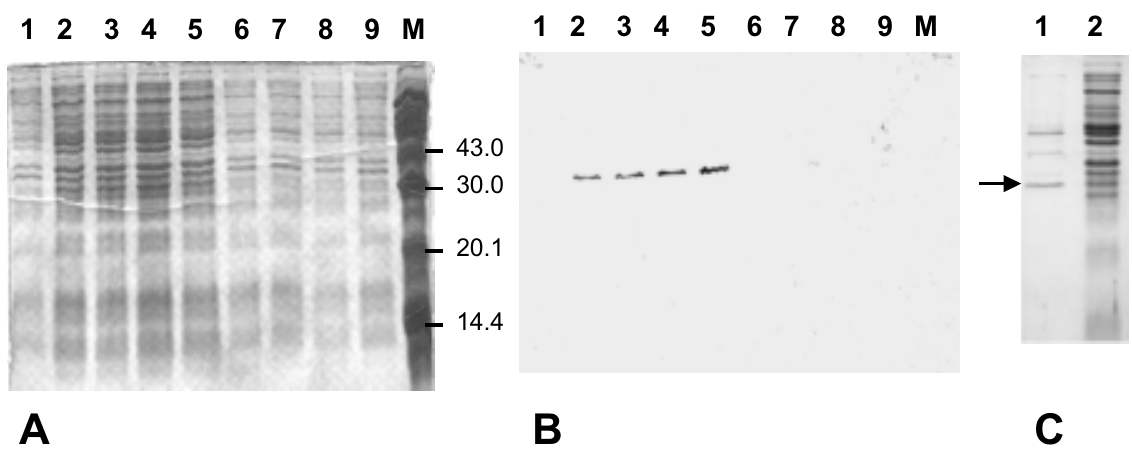
Fig. 1. Analysis by SDS-PAGE (15%) and Western blot of cellular extracts of Escherichia coli cultures harbouring the expression vector pTrcHisA 19-21. Panel A) SDS PAGE (15%) analysis of cellular extracts of cultures grown at 37 ° C (lanes 1 to 5) and 24 ° C (lanes 6 to 9). Lane 1, time 0, expression not induced. Lanes 2 and 3, respectively, 3 h and 5 h after induction with 0.3 mM IPTG. Lanes 4 and 5, respectively, 3 h and 5 h after induction with 1 mM IPTG. Lanes 6 to 9, same time and concentration of IPTG as in lanes 2 to 5. M, molecular marker, LMW (Pharmacia LKB Biotechnology, Sweden) with indicated molecular mass in KDa. Coomassie blue staining. Panel B) Western blot analysis of a twin gel of panel A. Panel C) SDS PAGE (15%) analysis of purified (lane 1) and unpurified (lane 2) rCP- CTV. The arrow indicates the position of the band that was used as immunogen.